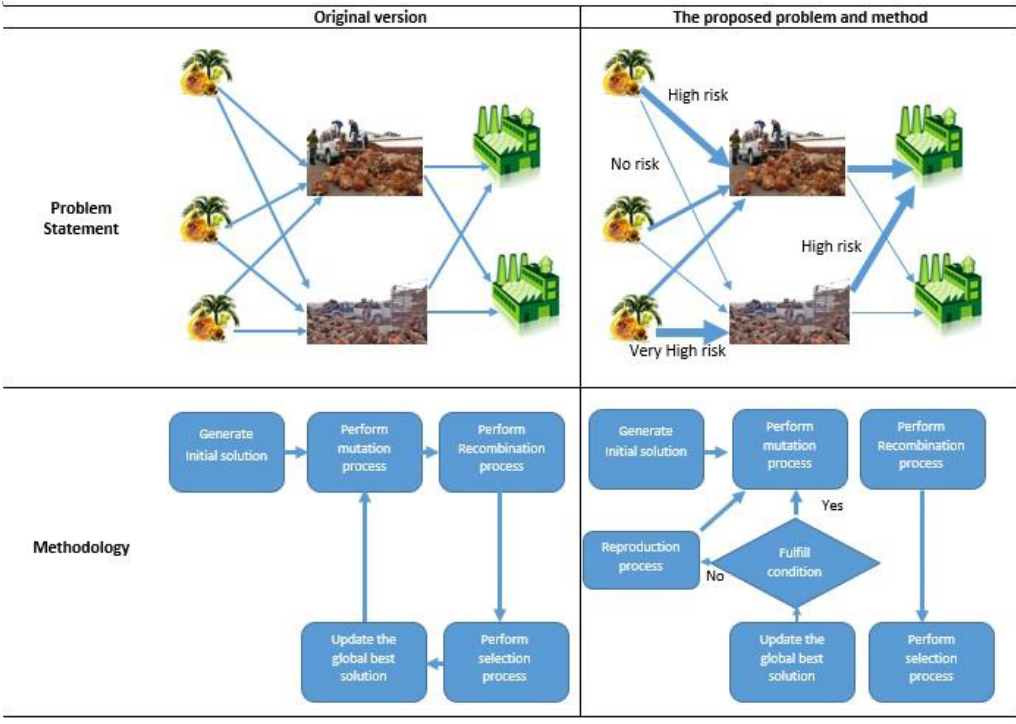
Figure 3. Original vs. proposed problem statement and methodology.